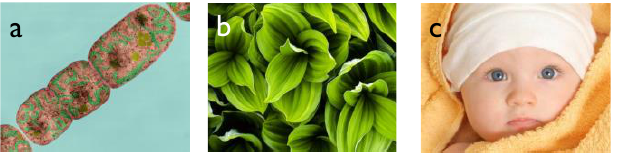
Figure 1. Life forms containing heme and HO. ( a ) cyanobacteria; ( b ) plants; and ( c ) animals. Heme and HO in Plants